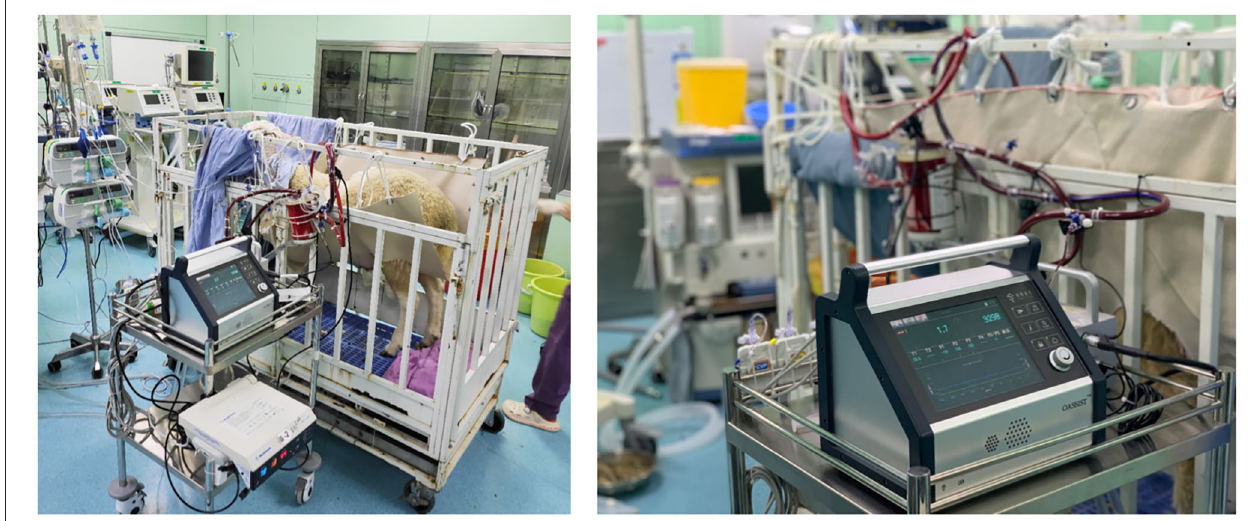
FIGURE 3 | The sheep stayed conscious. The oxygenators were fixed to the cages, while the control console and the pump drive were placed on a cart.